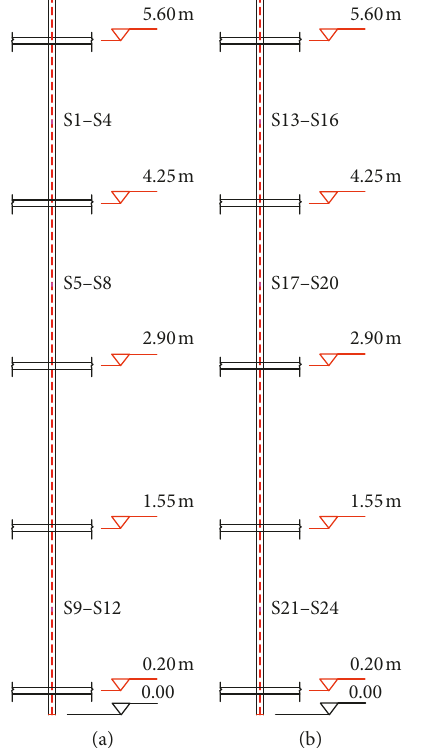
Figure 8: Layout of strain gauges on vertical rods of Models 1, 2, and 3. (a) A-3 rod. (b) C-6 rod.